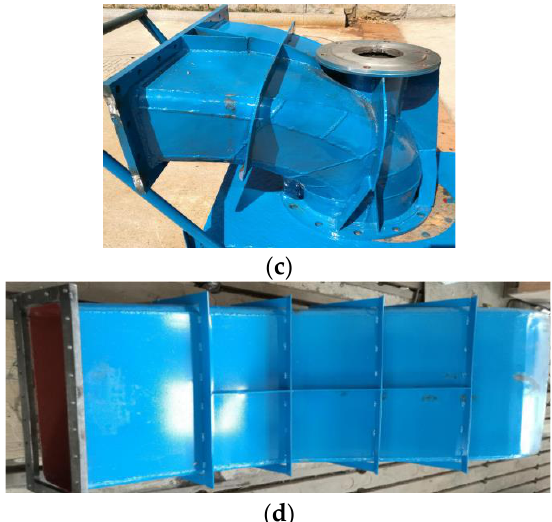
Figure 14. Mechanical four-quadrant multifunctional test bench [77]. ( a ) Pump model system dia- gram. ( b ) Inlet conduit physical map. ( c ) Outlet bend physical map. ( d ) Physical drawing of the outflow channel.